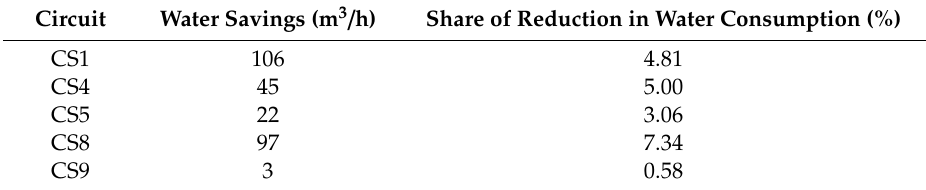
Table 8. Water Savings achieved by the application of VSD’s in